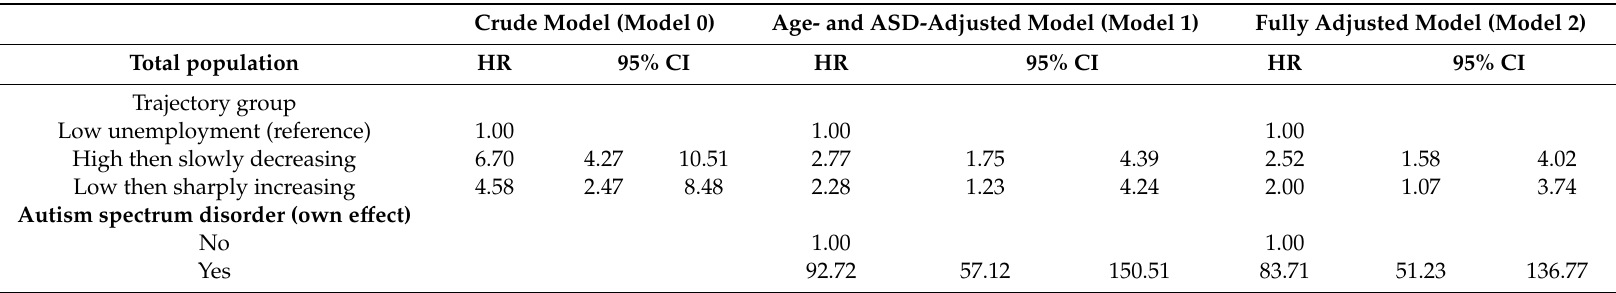
Table 3. Trajectory group membership ((1) Low, then sharply increasing unemployment (2) low unemployment (reference), (3) high unemployment, then slowly decreasing) as a predictor of subsequent risk of a disability pension. Hazard ratios, HR, and their 95% confidence intervals, 95%